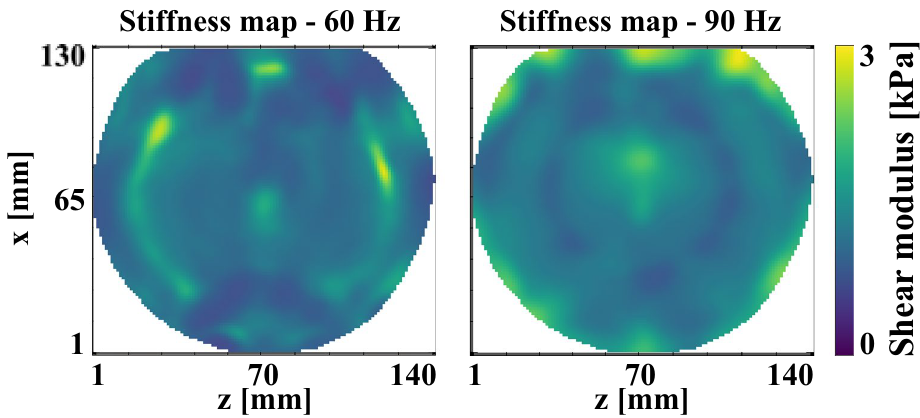
Figure 4. First experiment: shear storage modulus maps of homogeneous phantom A from x displacements with harmonic actuations of 60 Hz and 90 Hz and with an intensity of 137.5 mA peak-to-peak. Local maxima are assumed to be due to LFE limitations arising from the presence of the Lorentz force and wave reflections off boundaries. Images were acquired in the imaged plane indicated in Fig. 1a. The mean values over the entire field of views are µ 60 Hz =1546 ± 383 Pa and µ 90 Hz = 1768 ± 440 Pa.